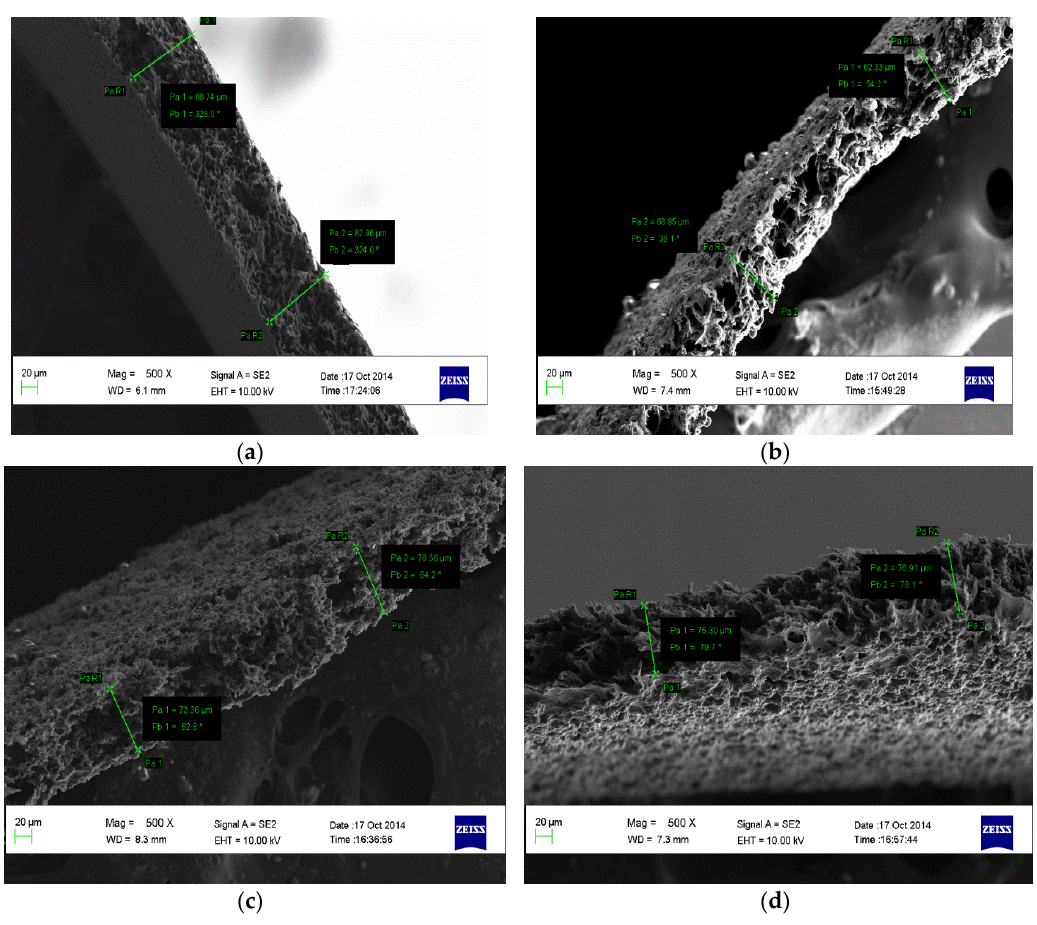
Figure 6. SEM images of the cross-sectional view of the membranes showing their porous structure ( a ) M1; ( b ) M2; ( c ) M3; and ( d ) M4.